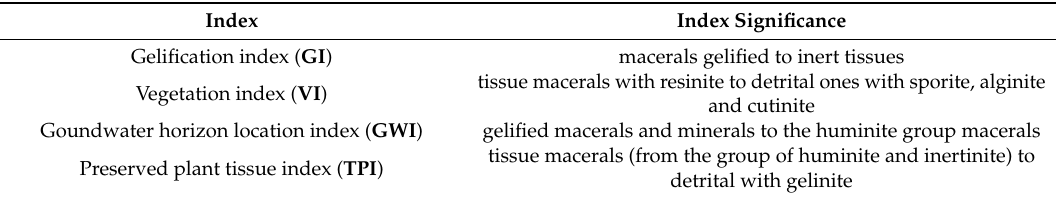
Table 1. Formulae and meaning of sedimentological indicators used to describe the sedimentological description of coaly